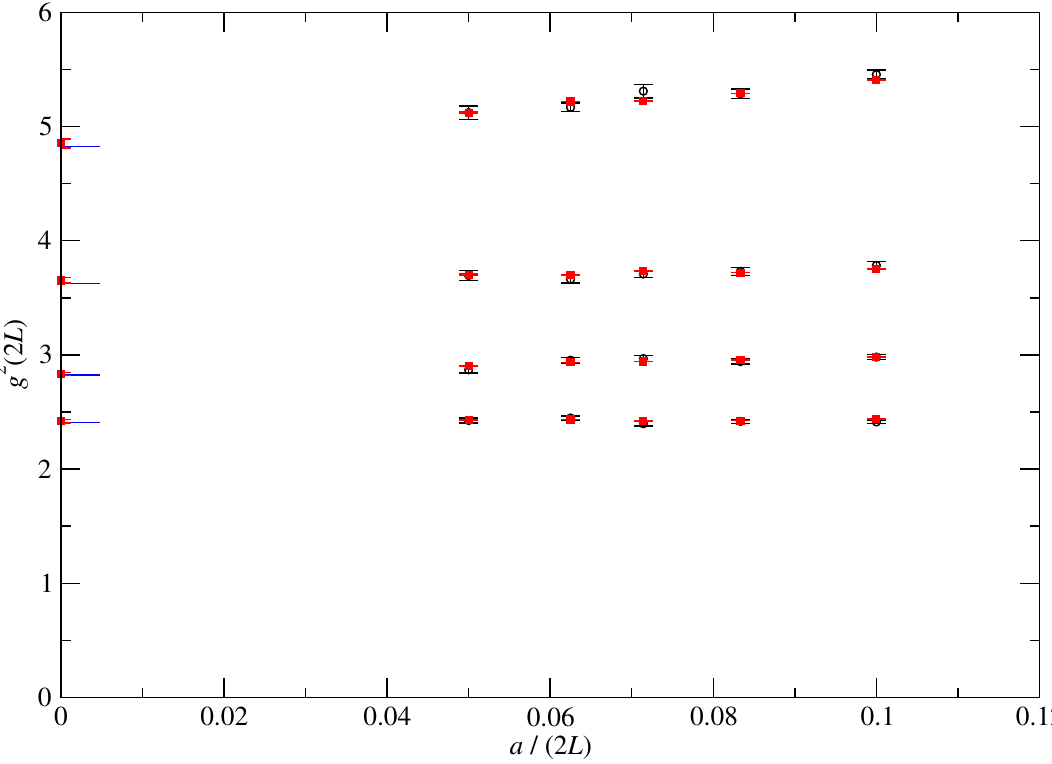
Figure 3 . Squared SU(2) couplings evaluated at 2 L (red squares), for four di(cid:11)erent values of g 2 ( L ), as a function of a= (2 L ), and the corresponding continuum-extrapolated values, in comparison with the two-loop predictions (horizontal blue segments on the vertical axis). The plot also shows the results from ref. [31] (black